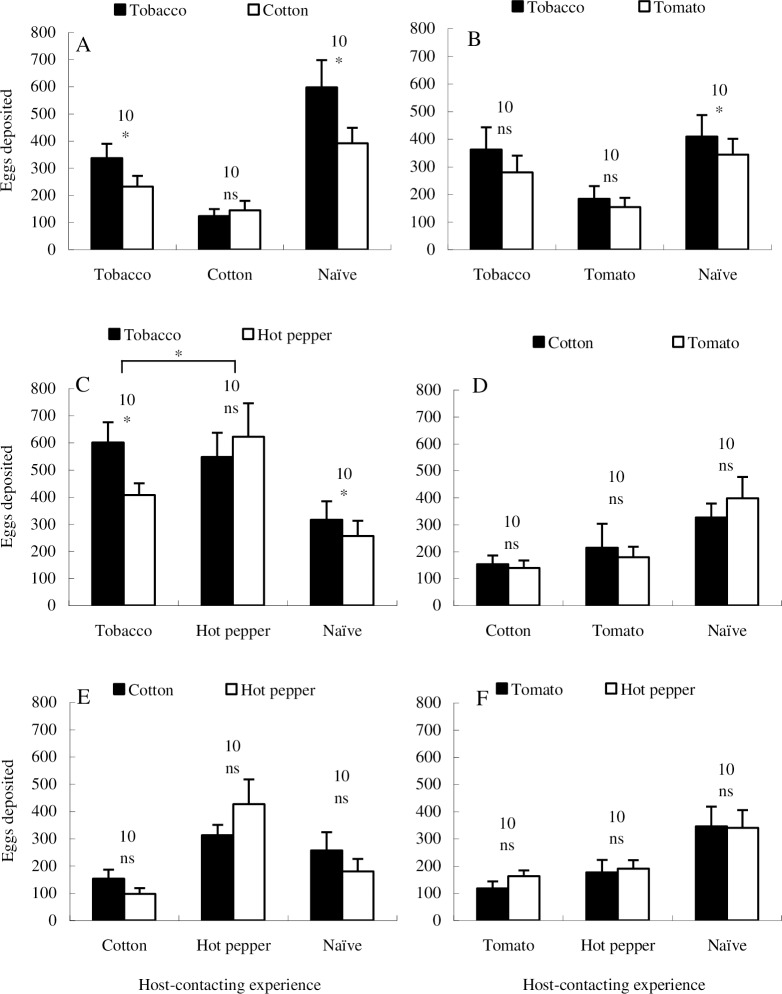
Effect of host-contacting experience after emergence on subsequent ovipositional choice response of H. armigera mated females.“*” indicates significant difference within group at P = 0.05 level, and “ns” indicates no significant difference within group, according to paired t test. The numbers attached to bar pairs indicate replications.